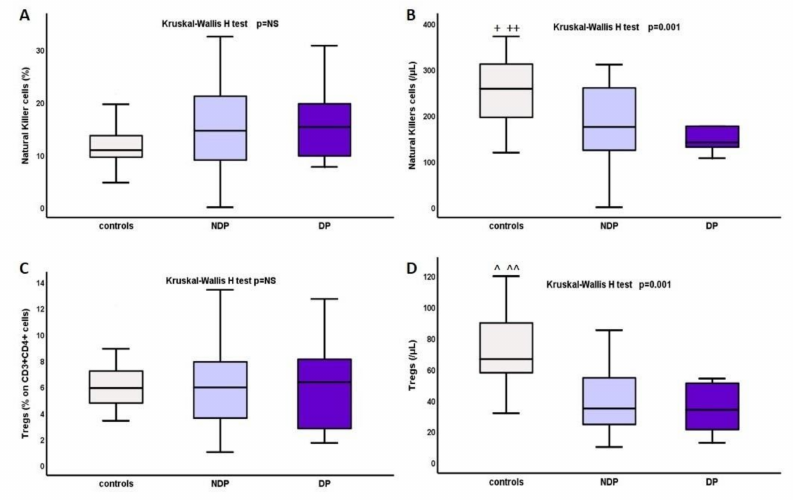
Figure 4. Differences in percentage and total cell count in ( A , B ) NK cells and ( C , D ) Tregs in DM, NDM, and controls, * p (DM vs. controls) = 0.03, ** p (DM vs. controls) = 0.001, ˆ p (DM vs. controls) = 0.02, ˆˆ p (DM vs. controls) =